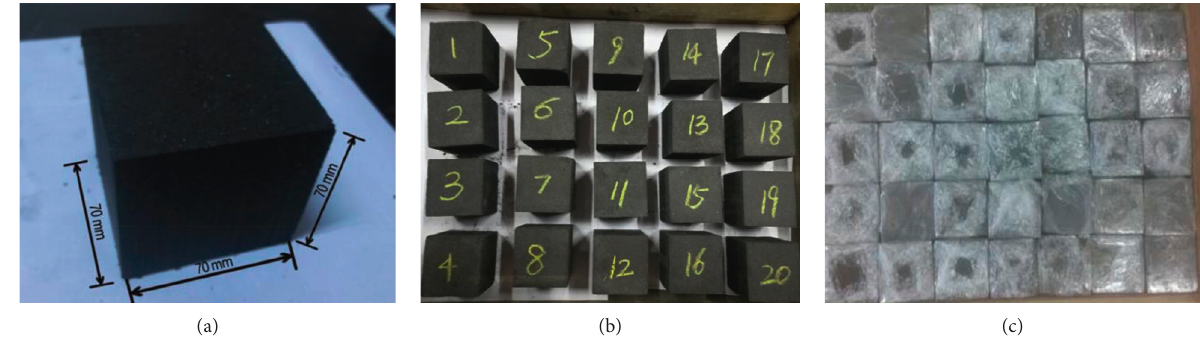
Figure 3: Test coal sample. (a) Briquette size; (b) briquette sample; (c) raw coal sample. Table 2: The main mechanical parameters of coal sample. Material